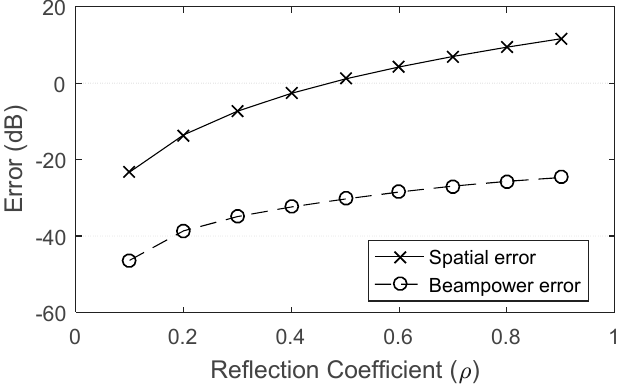
Figure 5. Spatial error and beam-power error with respect to the reflection coefficient.